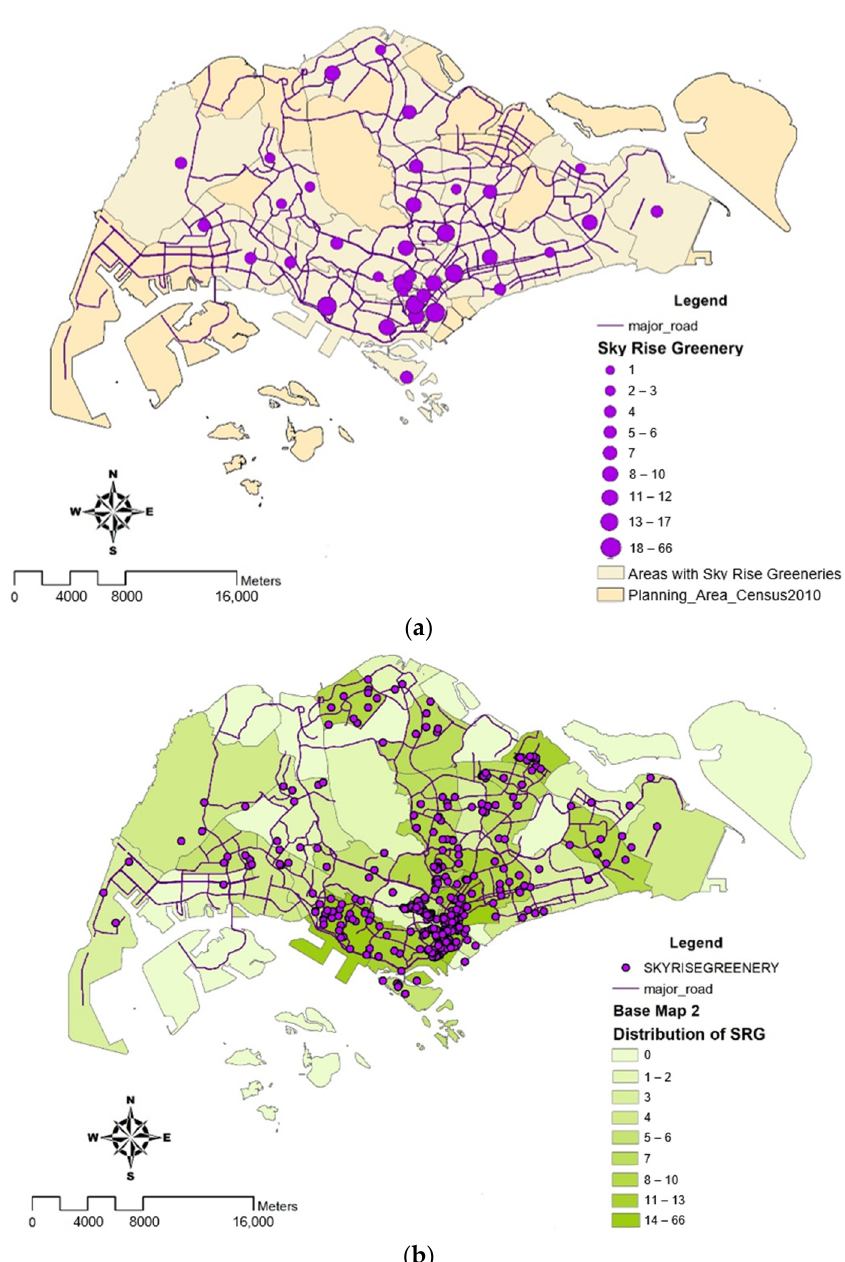
Figure 6. ( a ) The map displays the cluster of skyrise greenery (SRG) rooftops where larger cluster circle represents the higher number of green rooftops in a planning area. ( b ) Concentration of skyrise greenery (SRG) rooftops. The map displays the distribution of skyrise greenery rooftops using the classification technique ‘Natural Breaks’, with dark colors indicating large concentration of skyrise greenery rooftops and light colors indicating either no or tiny concentration of skyrise greenery rooftops.